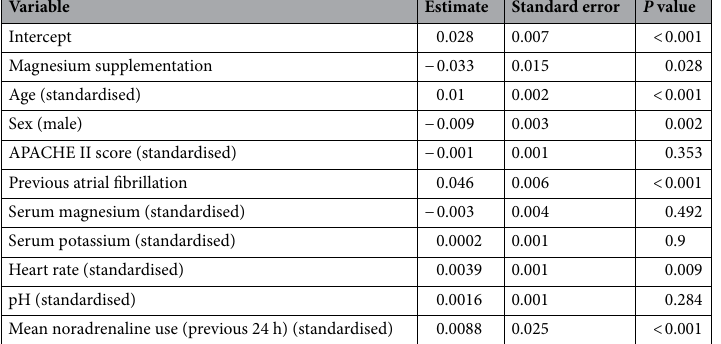
Table 4. Instrumental variable model estimates of the effect of magnesium supplementation on chance of experiencing an atrial fibrillation event.